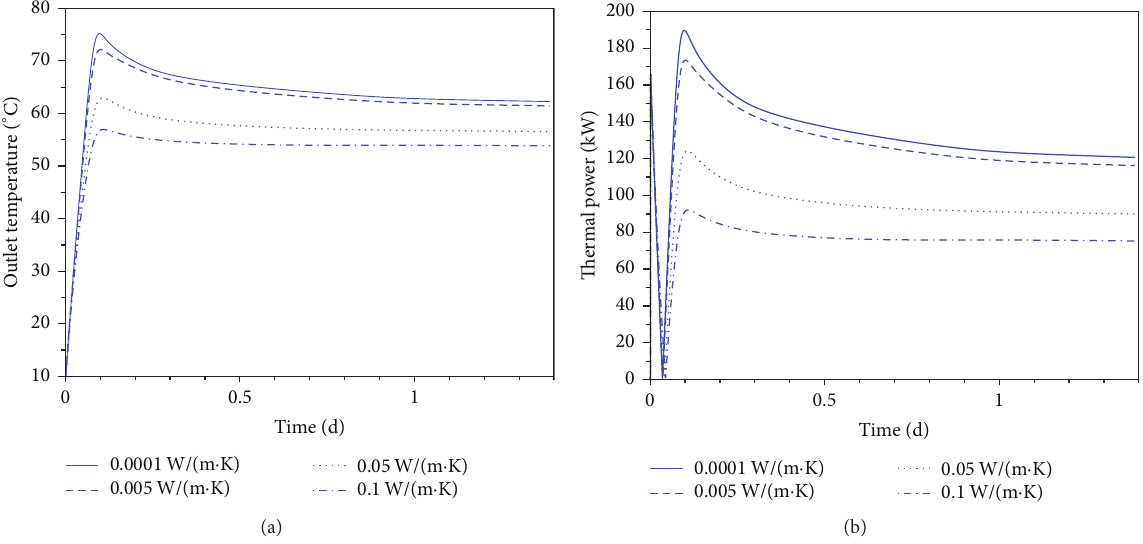
Figure 10: Variation of the outlet temperature and thermal power of the borehole heat exchanger with time for different thermal conductivities of the inner pipe , for a continuous operation of the borehole heat exchanger.